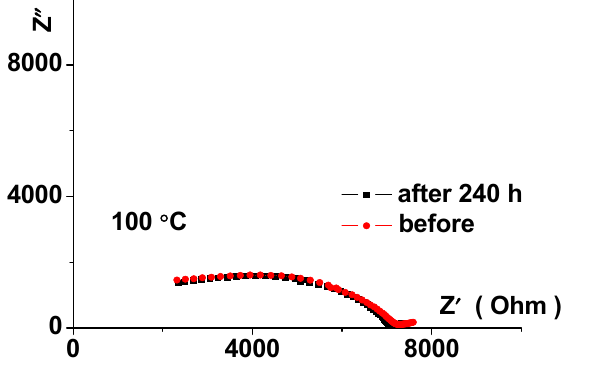
Figure 9. Impedance plots for Li | Li 3.8 Ge 0.9 S 0.1 O 4 | Li cell before and after isothermal exposure at 100 ◦ C for 240 h.